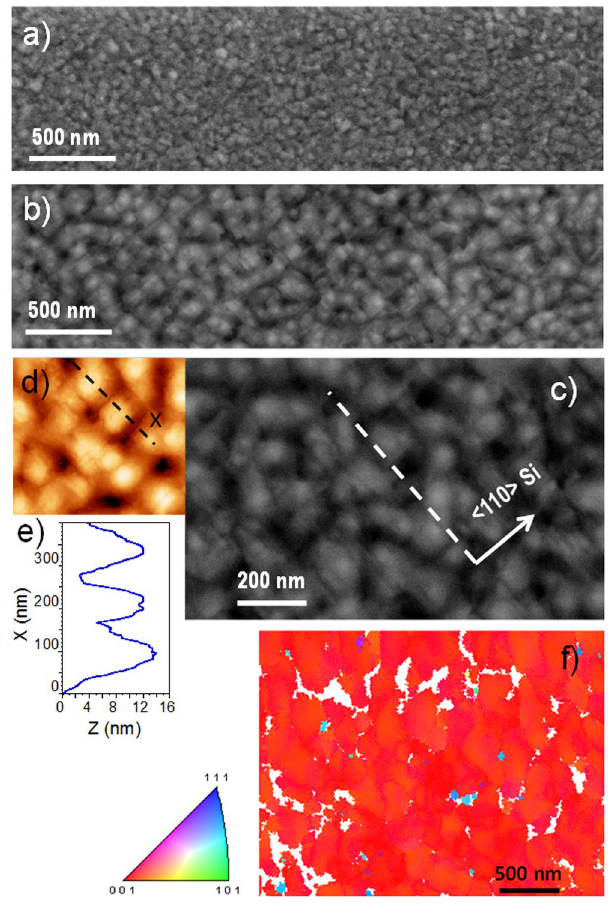
Figure 4. Microscopic characterization on the top-surface of Cu films. SEM micrographs (top view) of the surface morphology of ( a ) DCMS and ( b ) HiPIMS Cu films (~150 nm thick) grown at − 130 V bias. ( c ) SEM and ( d ) AFM images at higher magnification showing the cubic domains network for the HiPIMS film. ( e ) Surface profile taken along the “x” direction (see dashed line in ( d )). ( f ) Orientation map measured from EBSD for the Cu HiPIMS film at − 130 V and corresponding color code. The slight variations in red hue correspond to max. 5–6° misorientation from the [001]